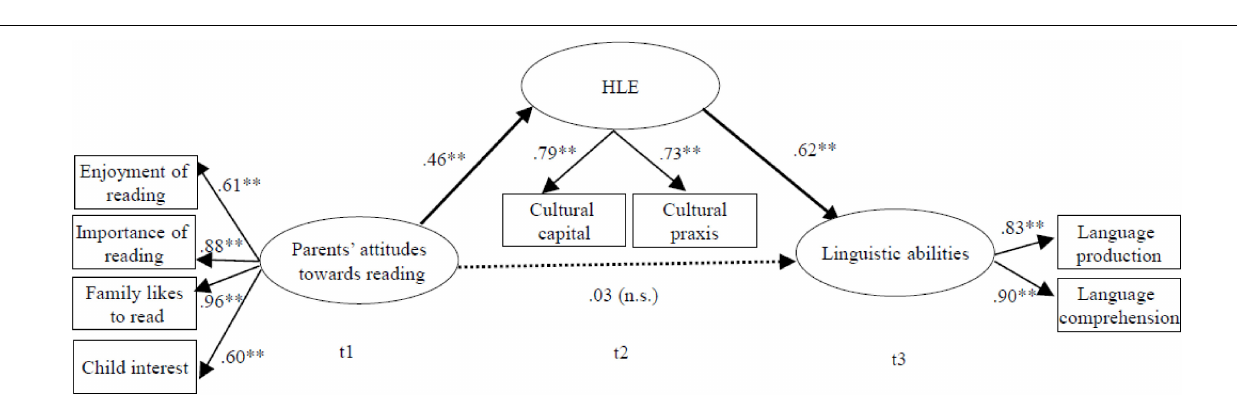
FIGURE 1 | Parental attitudes as a predictor of children’s linguistic abilities. N = 133. Standardized beta coefficients with ** p < 0.01; * p < 0.05. HLE, home literacy environment. All analyses are controlled for age, sex, intelligence, and parental socioeconomic status (SES) (occupational prestige); χ 2 (23) = 37.92, p > 0.05, root mean square error of approximation (RMSEA) = 0.07, comparative fit index (CFI) = 0.97, Tucker–Lewis Index (TLI) = 0.94, standardized root mean residual (SRMR) = 0.05.